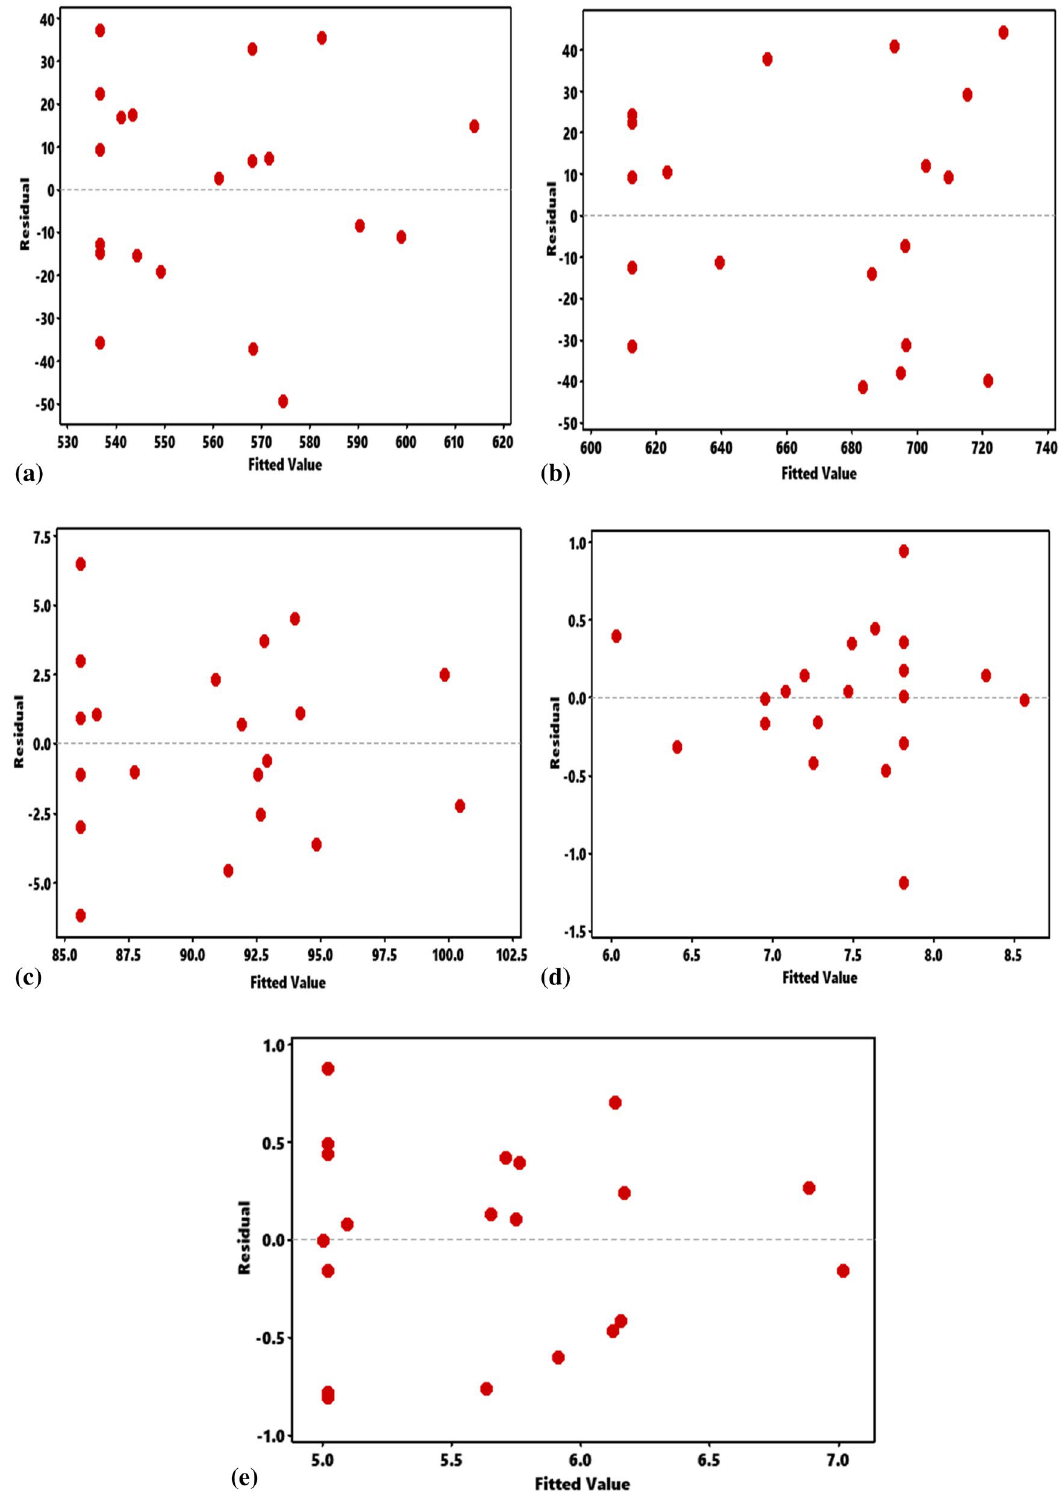
Figure 2. Normal probability plot of residuals for responses. ( a ) Ultimate tensile strength, ( b ) hardness, ( c ) impact strength, ( d ) elastic modulus, ( e ) compressive